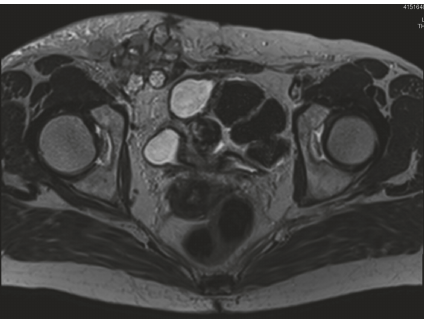
Figure1:T2-weightedaxialMRimage,showingamultilobularmass consisting of cystic and solid components at the right inguinal site.